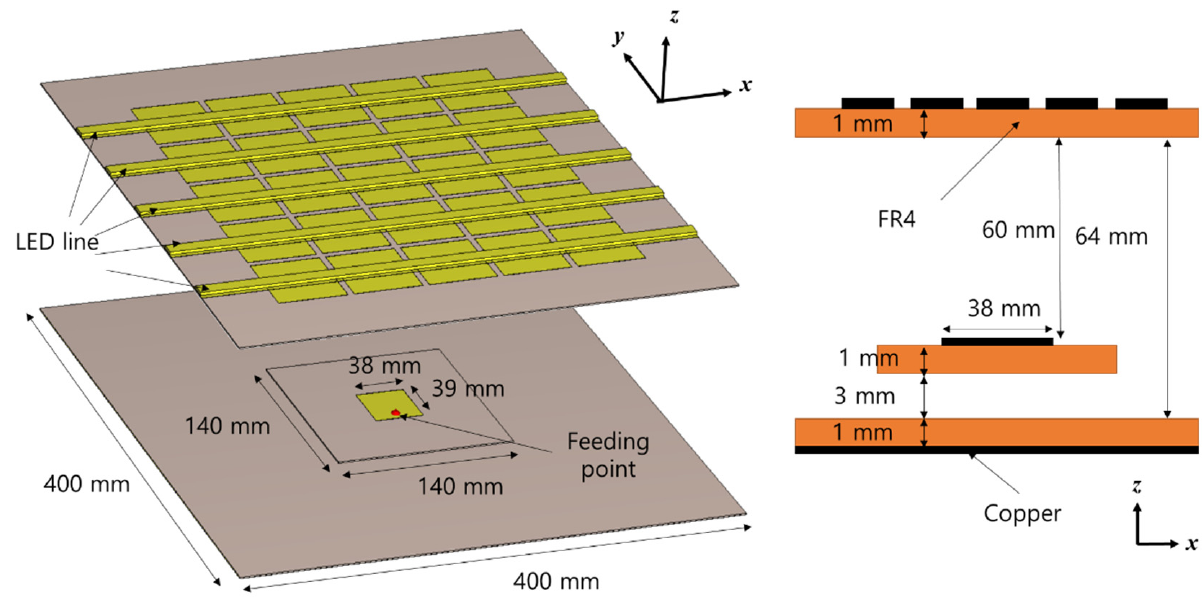
Figure 2. Structure of the proposed antenna.